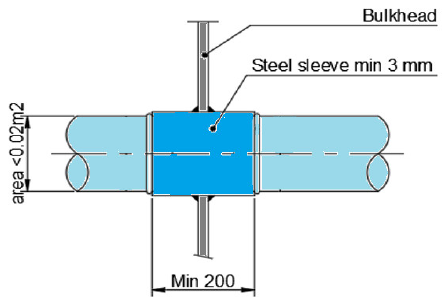
Figure 6. A class fire division—penetration of thin plate ventilation duct, area ≤ 0.02 m 2 .